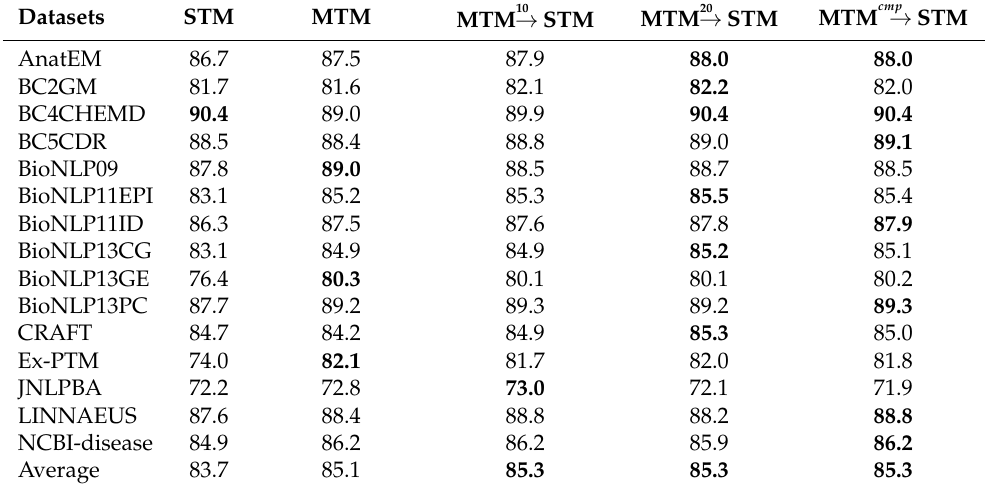
Table 6. Results comparison of our different fine-tuned approaches of the MTM ( MTM → STM ).